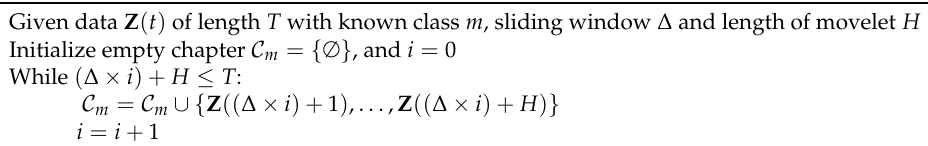
Algorithm 1 Pseudocode for Generating a Movelet